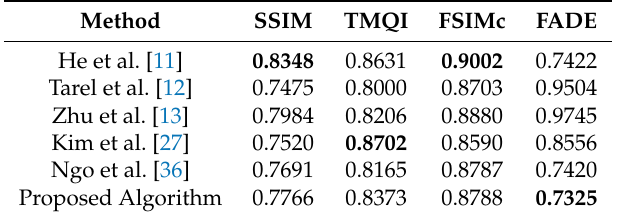
Table 4. Average SSIM, TMQI, FSIMc, and FADE scores on D-HAZY dataset.